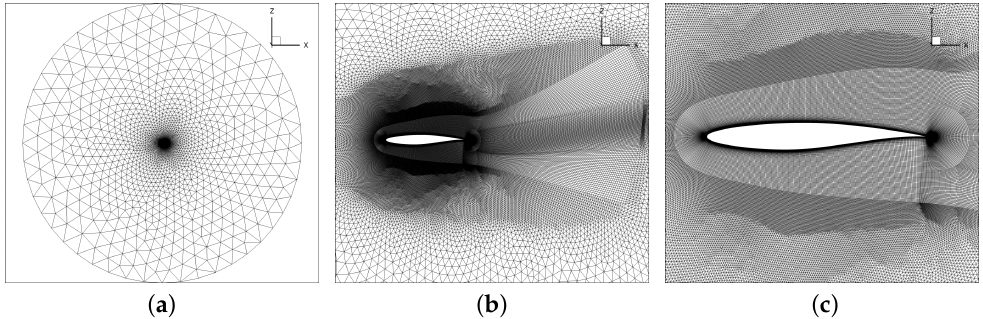
Figure 1. Hybrid CFD mesh for the RAE2822 airfoil with about 240.000 nodes. ( a ) Far-field mesh, ( b ) Quads in the near-field and the wake, ( c ) Close-up of the near-field